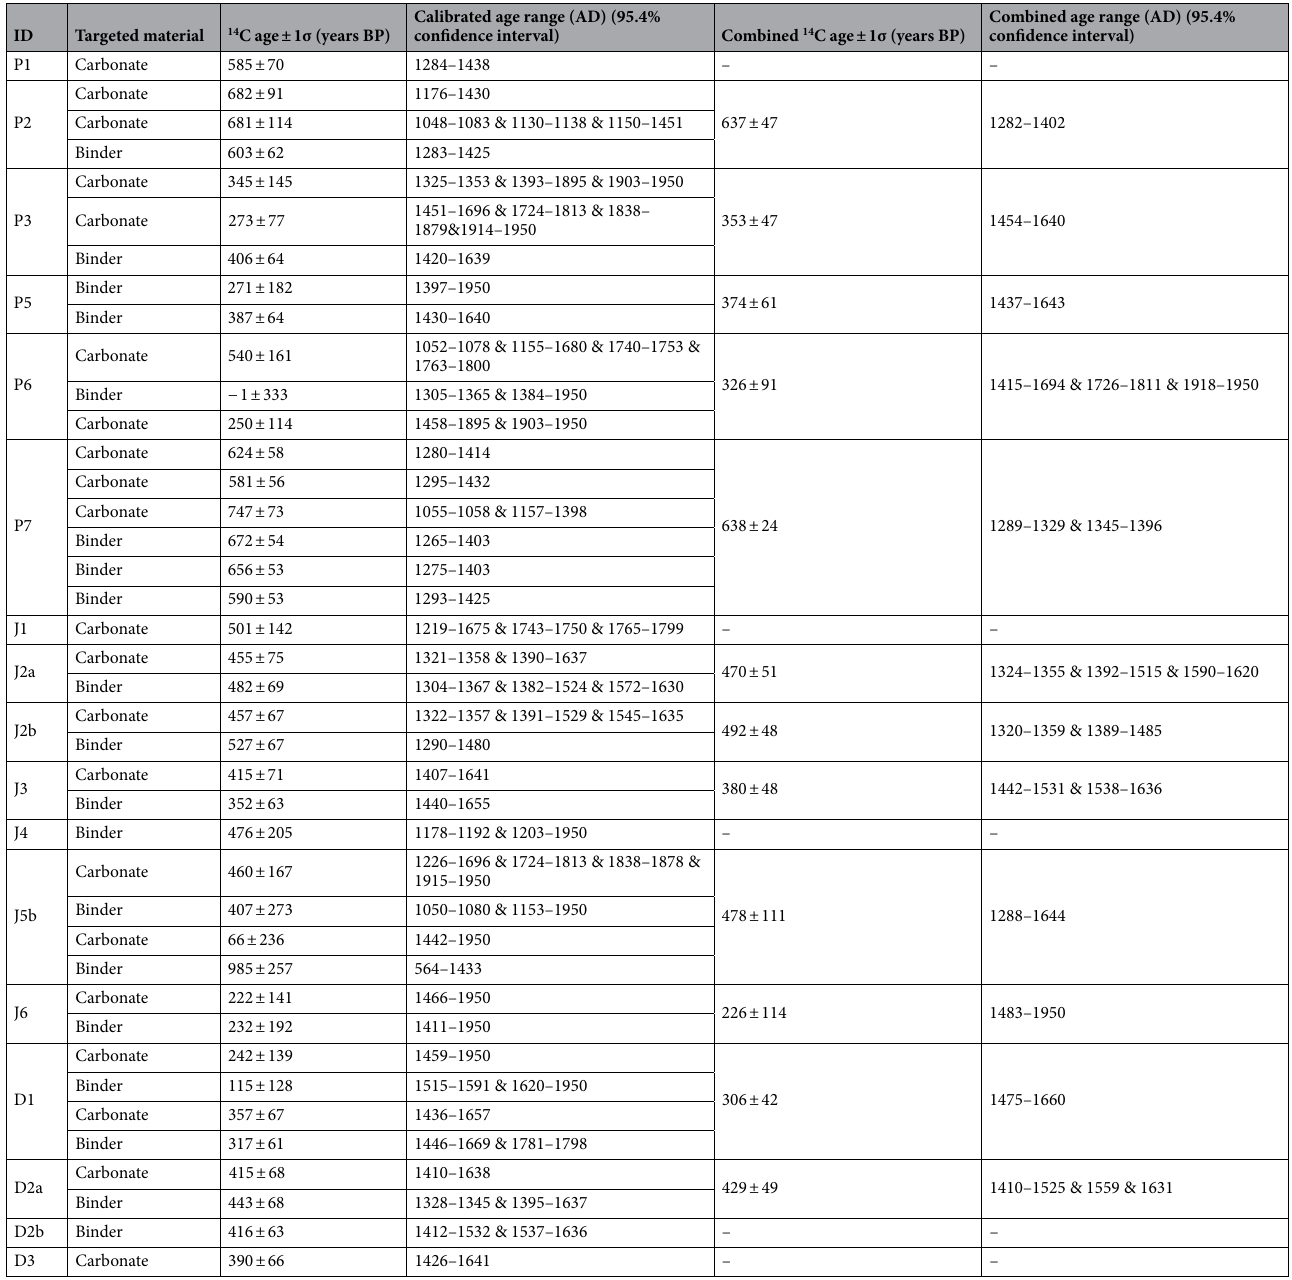
Table 3. Calibrated age ranges of the paint samples. The summary of results is organized by sample ID, targeted material, the 14 C ages with 1σ uncertainty and the respective calendar ages calibrated using the software Oxcal 4.4. 26,27 with the IntCal20 calibration curve 29 . The last two columns represent the 14 C ages